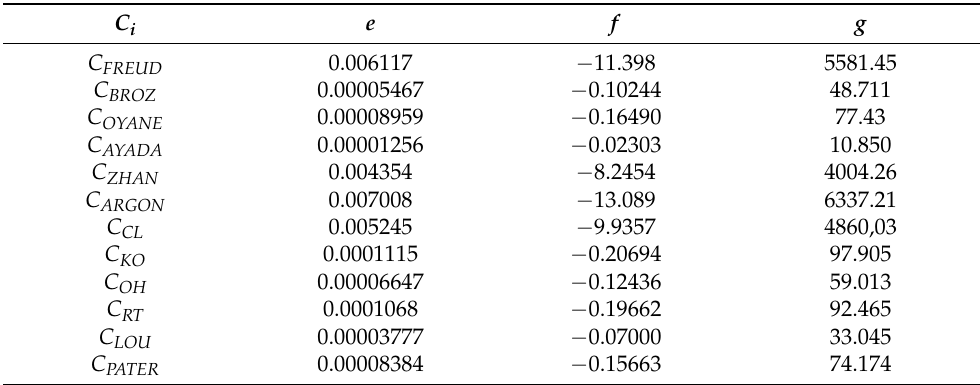
Table 2. Parameters of Equation (27) describing the relationship between the critical damage C i and the forming temperature T .